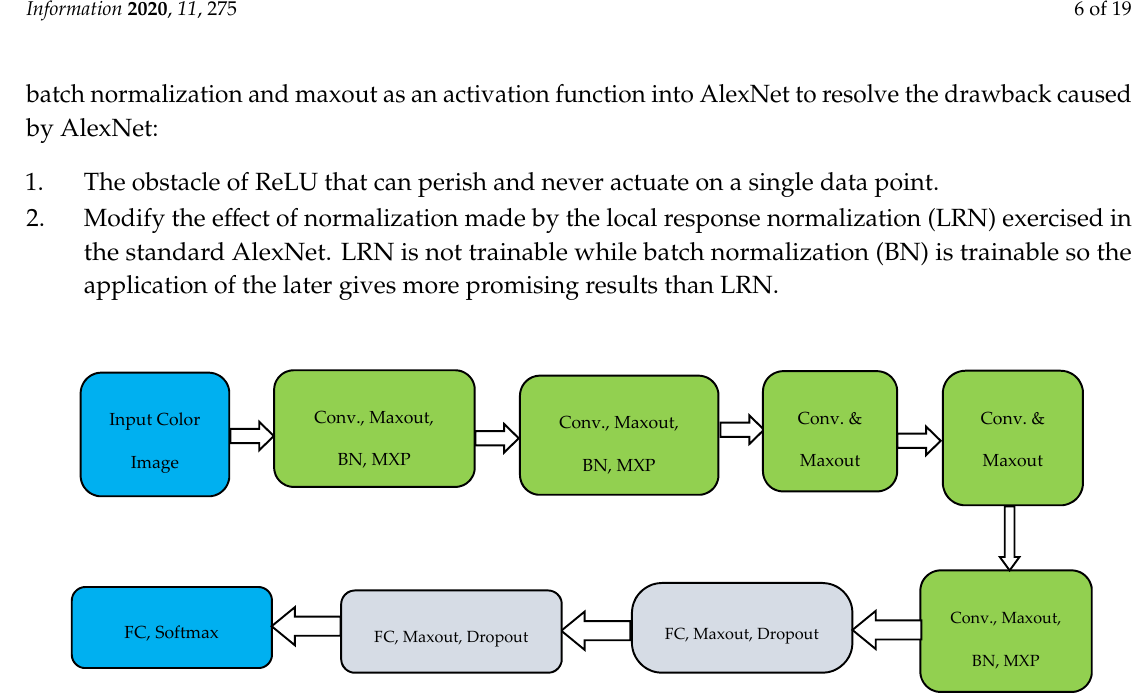
Figure 3. The overall architecture of AlexNet [23].